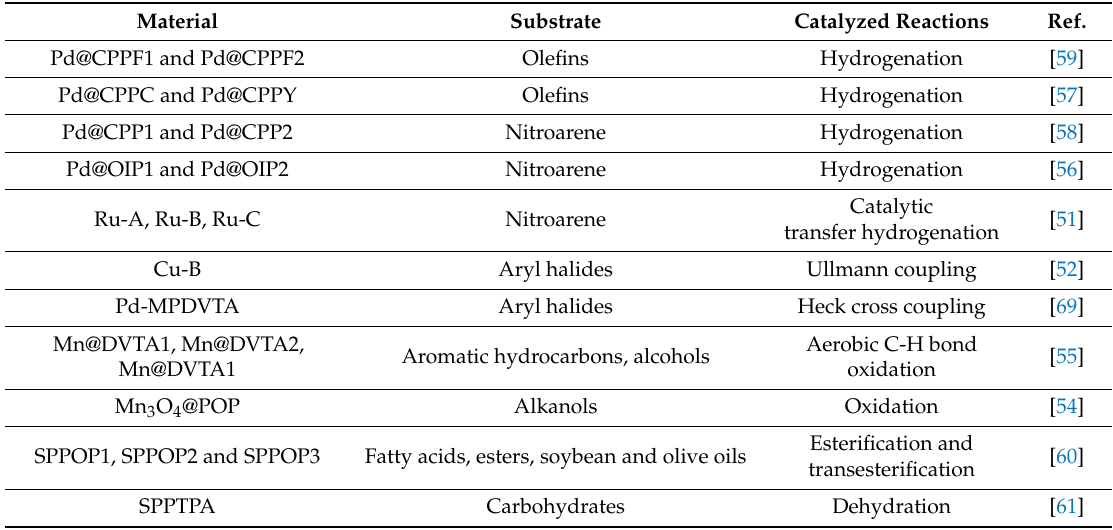
Table 4. Catalytic activity of supported metal nanoparticles and functionalized porous organic polymers. Material Substrate Catalyzed